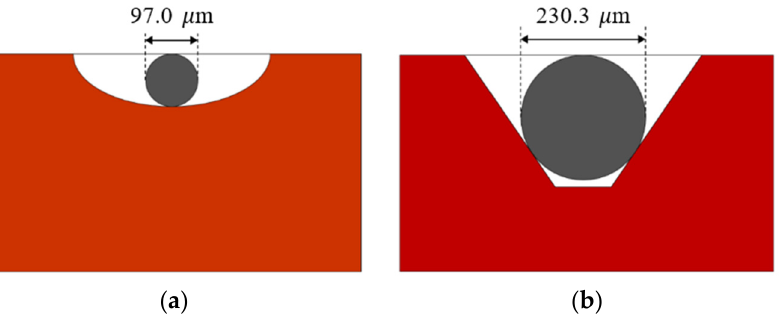
Figure 5. Maximum particle size that can pass through the disc groove: ( a ) Semi-elliptic groove; ( b ) Trapezoidal groove.